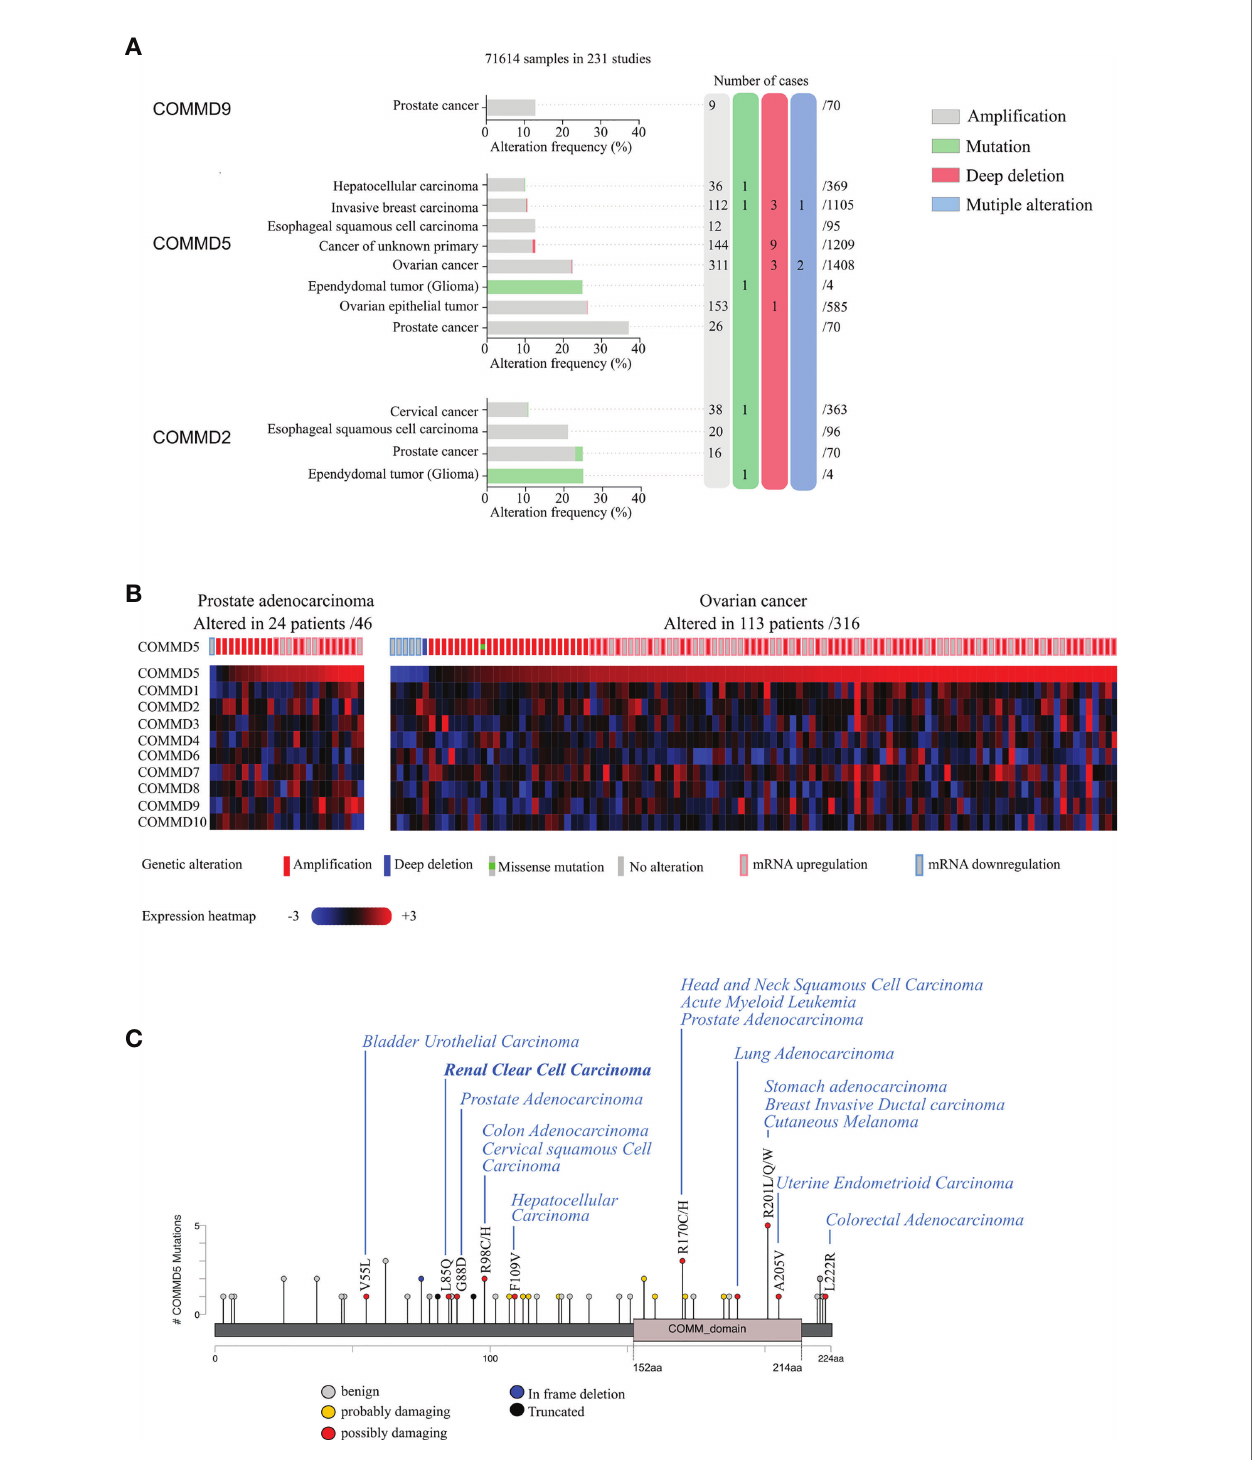
FIGURE 2 | Genetic alterations and tissue expression pro fi le of COMMD proteins and their association to different types of carcinoma. (A) cBioportal database was used to analyze mutations and copy number alterations of COMMD proteins in 231 studies (71,641 samples). Only COMMD2, COMMD5, and COMMD9 presented >10% CNV or mutations and were described in this fi gure. Genetic alterations of COMMD5 in different types of cancer showed the highest frequency of alterations in prostate and ovarian cancers. (B) Heatmap and copy number variations of COMMD proteins in ovarian cancer and prostate adenocarcinoma TCGA data (n = 46 and n = 316, respectively) obtained from cBioPortal. (C) Graphical summary of COMMD5 mutations from TCGA carcinoma studies mapped across the